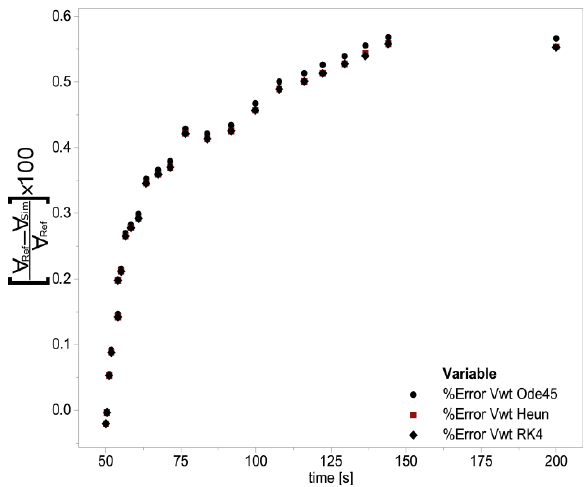
Figure 13. Approximation error for calculations of total water volume in the boiler.